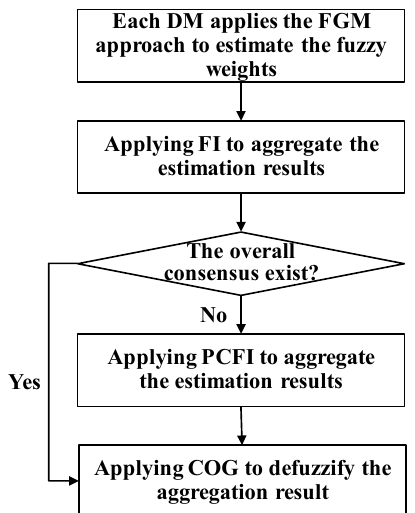
Figure 1. The procedure of the partial-consensus posterior-aggregation fuzzy analytic hierarchy process (PCPA-FAHP) approach.